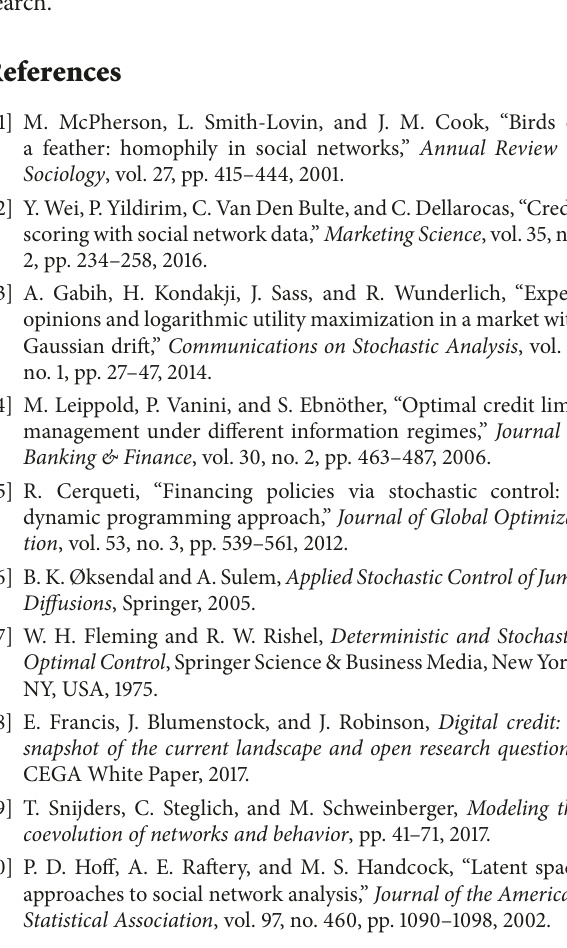
Figure 2: Left: Plot of variances 𝜆 𝐻 𝑡 when no. of friends 𝜂 𝑡 = 0 and = 5 Right: Plot of variances 𝜆 𝐻 𝜂 𝑡 𝜂 = 𝜌 𝑡